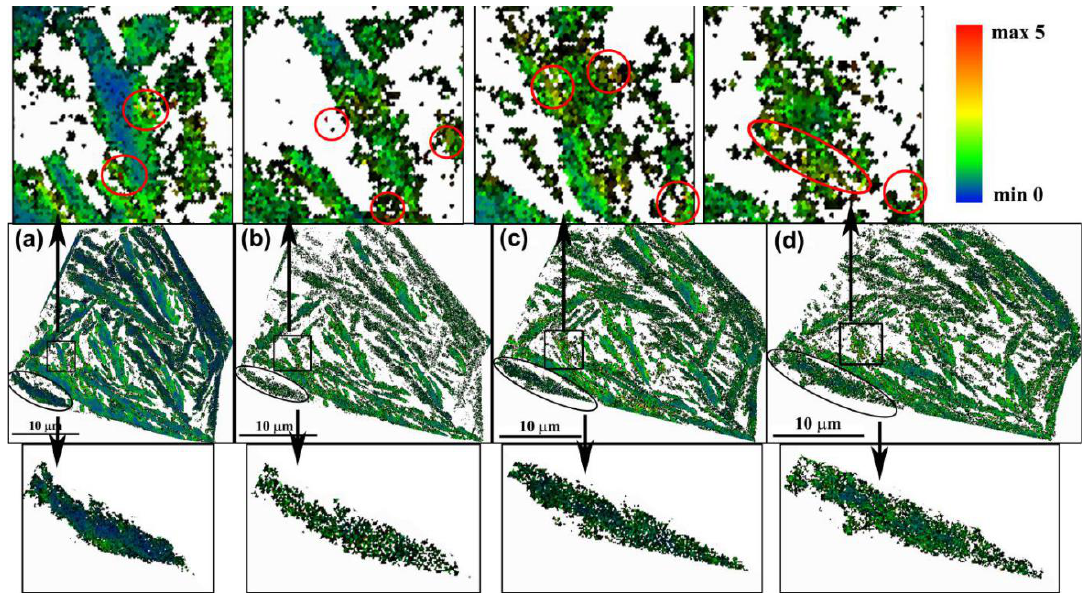
Figure 9. Distribution of KAM for bainitic ferrite (BF) at different strains: ( a ) 0, ( b ) 0.025, ( c ) 0.054, and ( d ) 0.104. Note: the red ellipses indicate the high-strain regions.